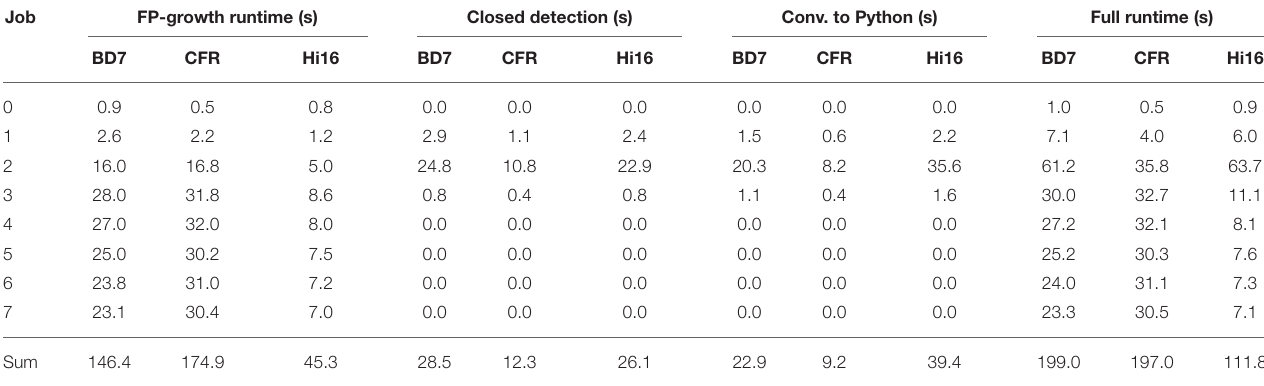
TABLE 4 | Runtime of the multi-threaded implementation on the ADLINK Express-BD7, the ADLINK Express-CFR-E and the HiSilicon Hi1616 microserver. Job FP-growth runtime